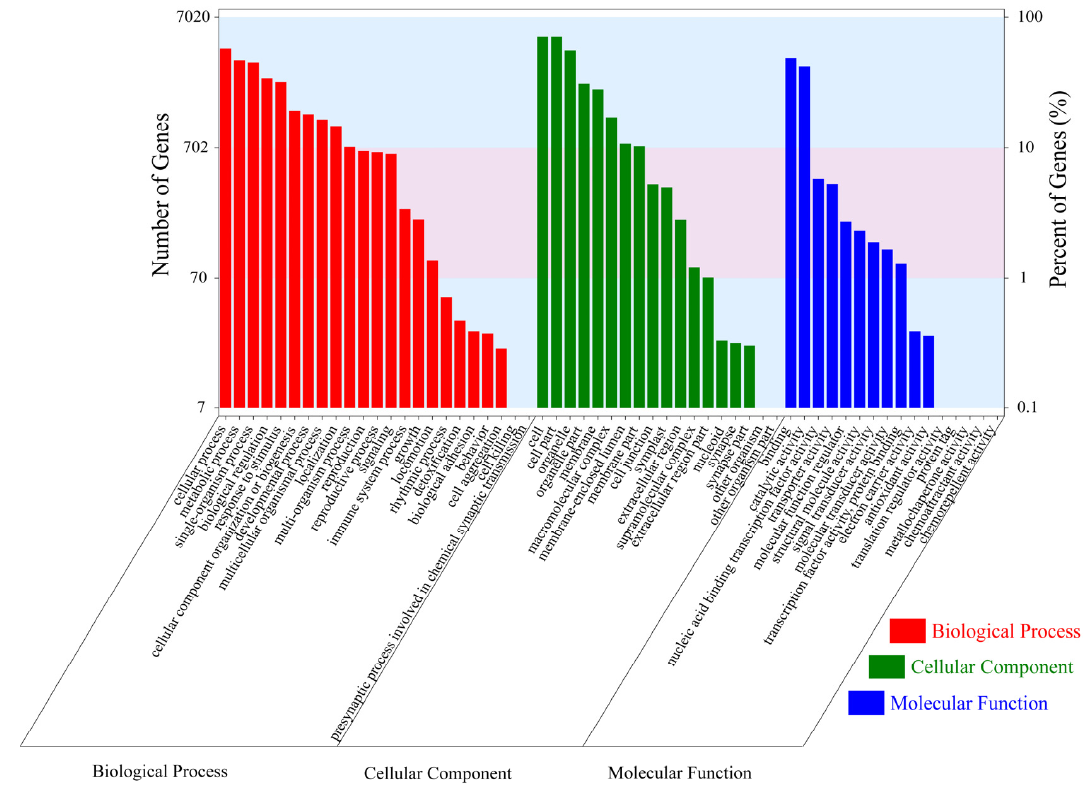
Figure 2. GO classification of C. macrophyllum .